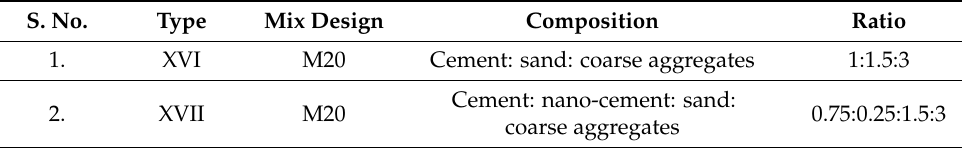
Table 8. Work plan of compressive strength test on concrete.